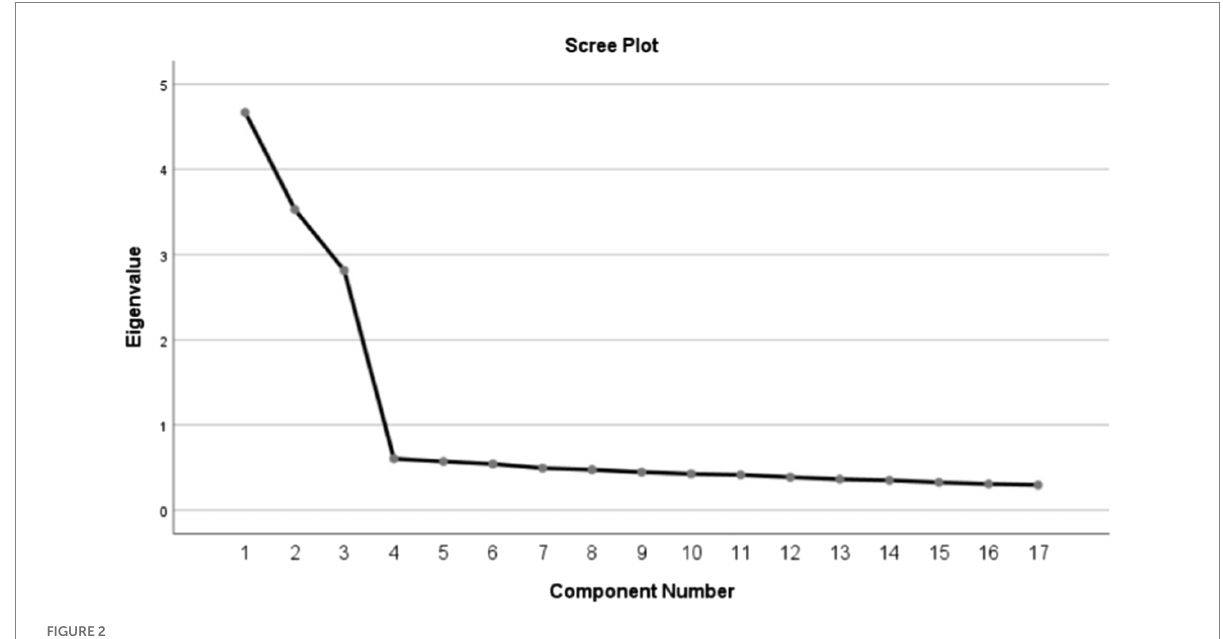
FIGURE 2 Screen plot of exploratory factor analysis for the Chinese version of the FH scale.